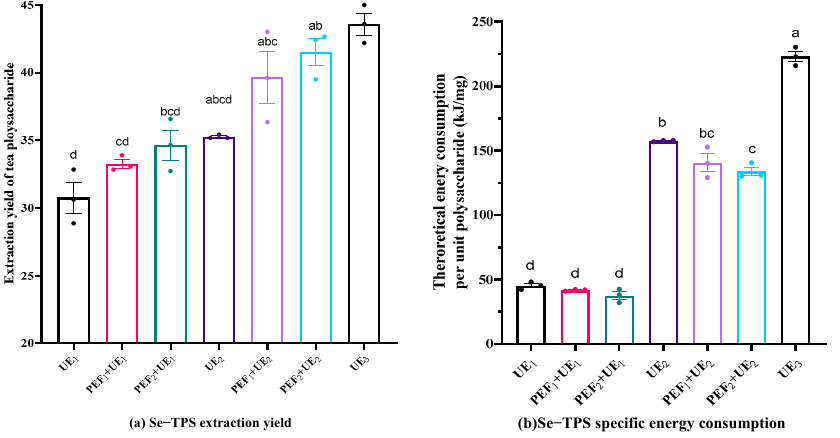
Figure 3. Se − TPS extraction yield ( a ) and specific energy consumption ( b ) in UE and PE + UE processes. Different letters above the columns represent extraction yield and energy consumption differ significantly ( p < 0.05).